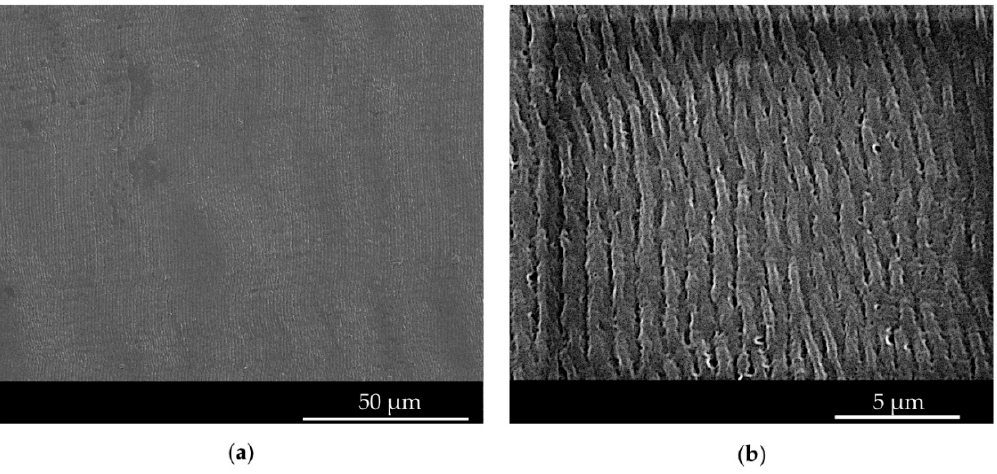
Figure 7. SEM images of the ripples replicated on PS samples. ( a ) Low magnification SEM picture of a PS sample molded at a mold temperature of 50 °C; ( b ) high magnification pictures of PS molded at 50 °C.